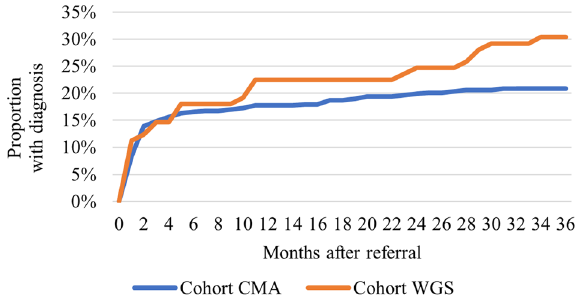
Figure 3. Cumulative progression of diagnostic yield per